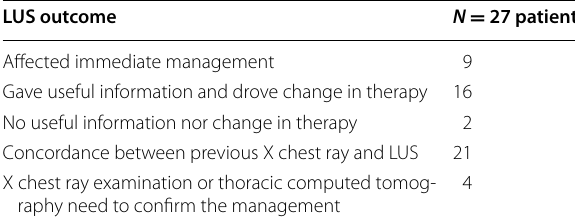
LUS lung ultrasound